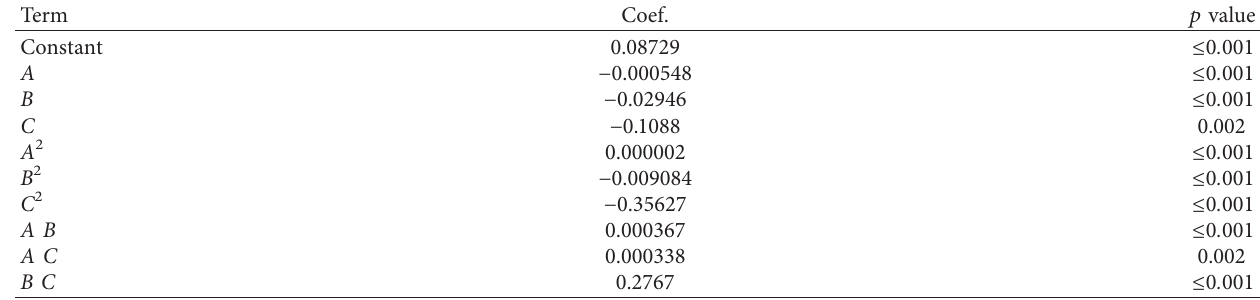
Table 4: Estimated regression coefficients for vibration.